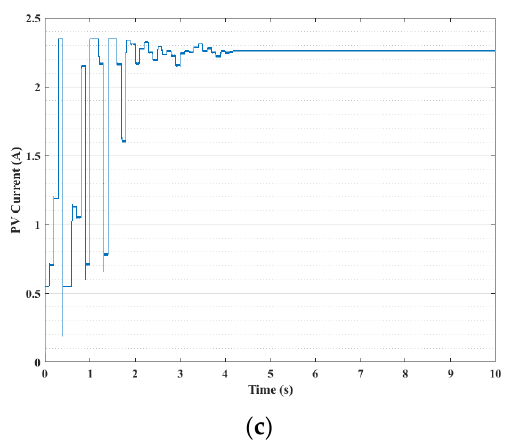
Figure 13. Modified LFO at PSC1. ( a ) power ( b ) voltage ( c ) current. PSC 2 as explained in Table 4 is created. The proposed modified LFO is tested under PSC 2. Based on Figure 14, the simulation results indicate that the proposed modified LFO can distinguish GMPP at 11.1 W. The algorithm is stable, and no steady-state oscillations occur.